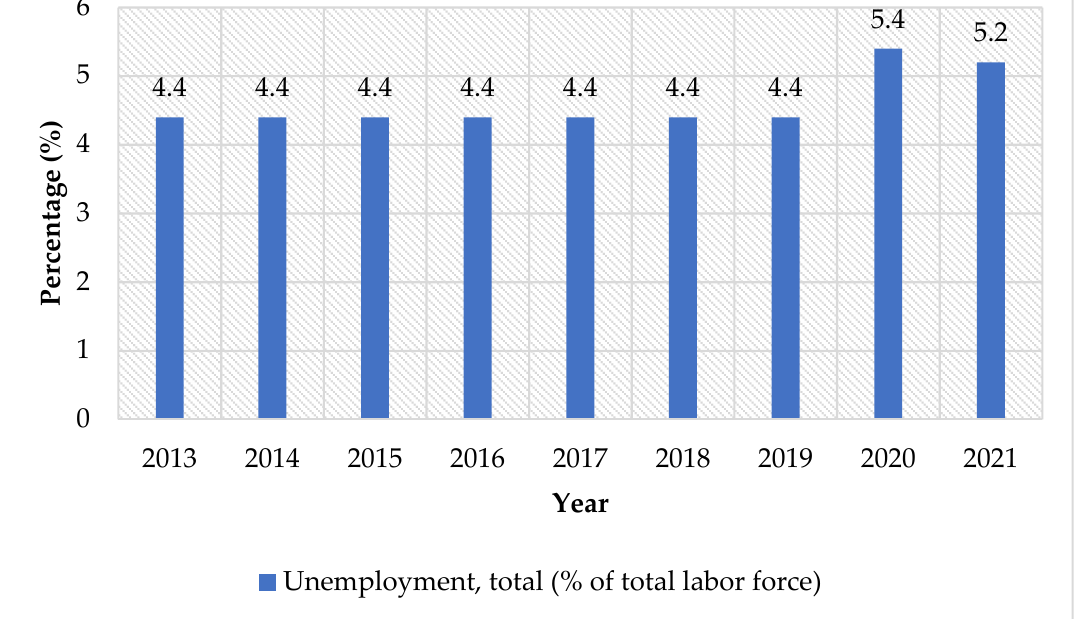
Figure 1. Total unemployment rate of Bangladesh from 2013 to 2021. Source: Created by the authors, based on the data from The World Bank (2022).